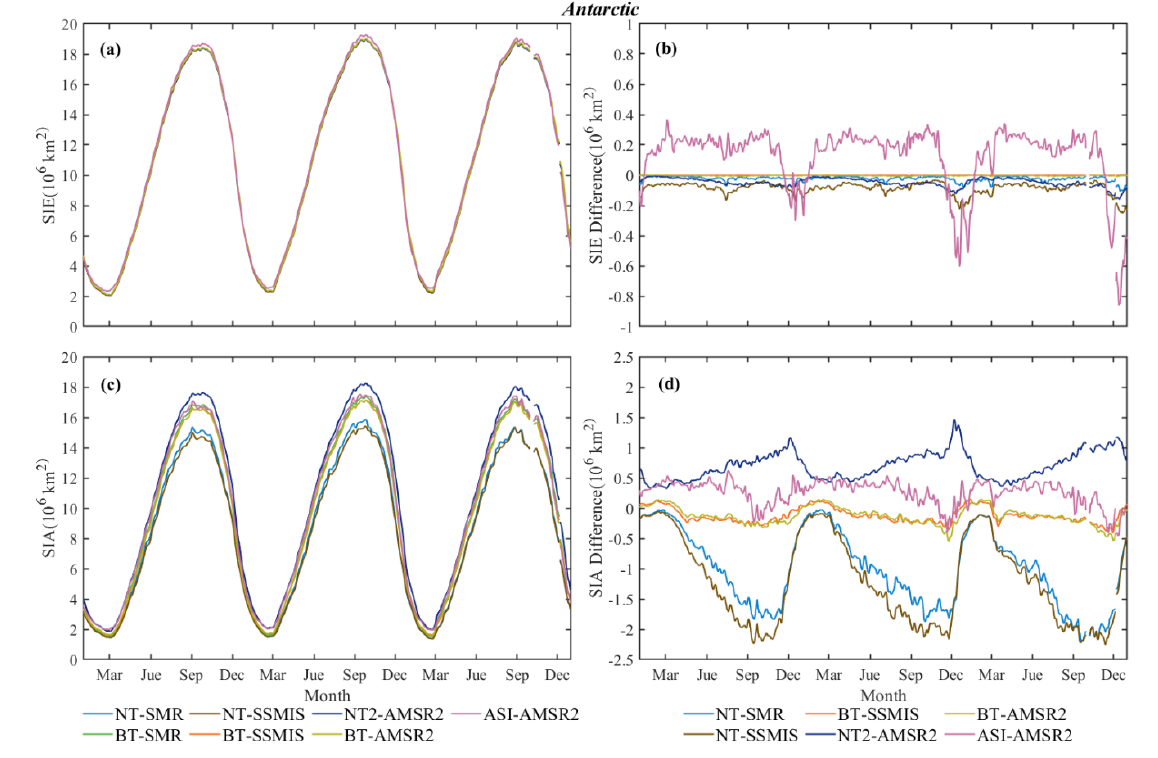
Figure 16. Same as in Figure 15 but in the Antarctic.